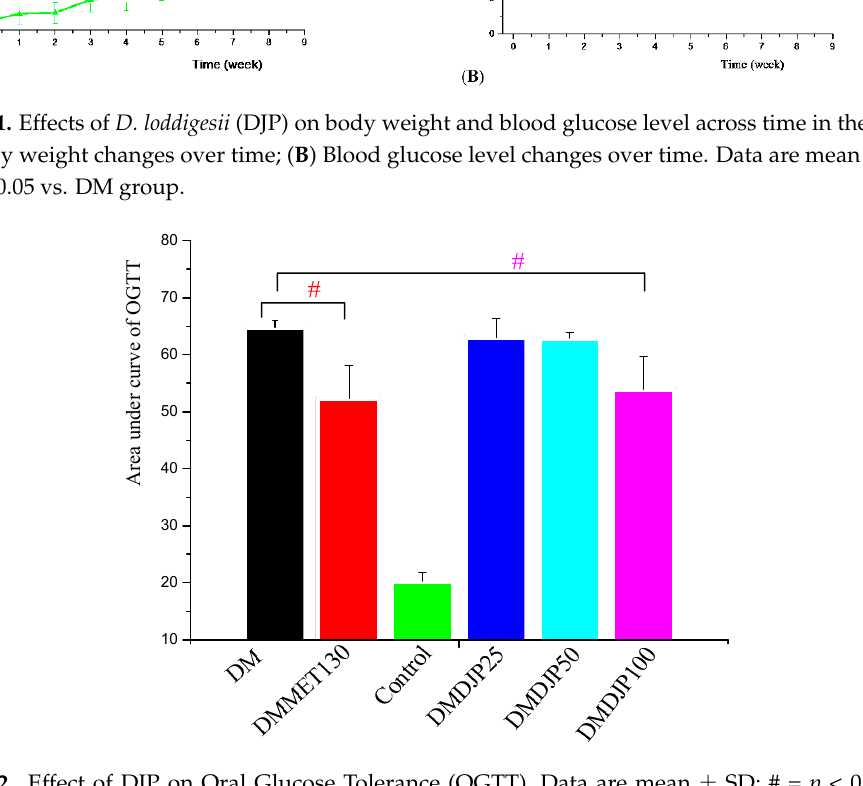
Figure 2. Effect of DJP on Oral Glucose Tolerance (OGTT). Data are mean ± SD; # = p < 0.05 vs. DM group.